Question: What caption would you write for this figure?
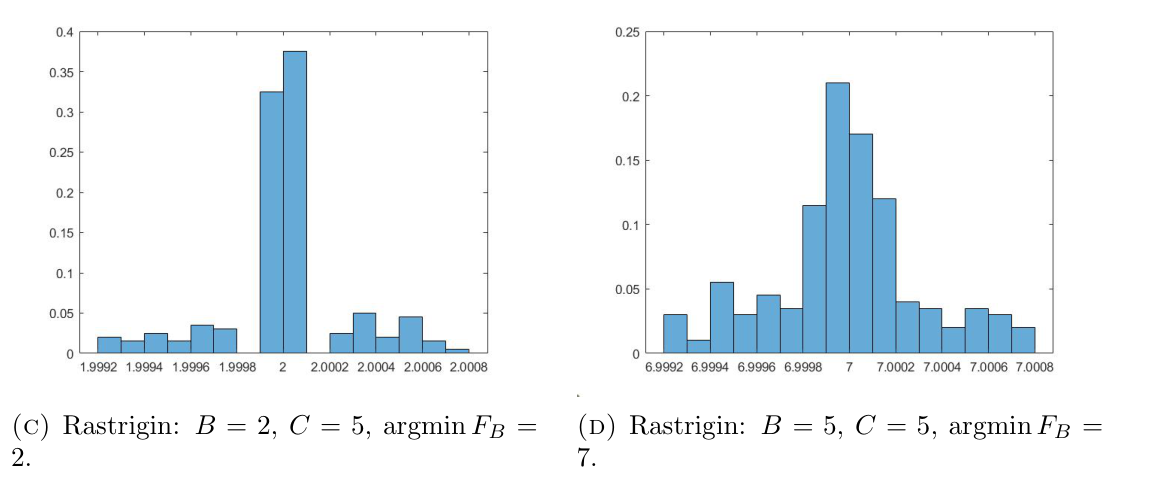
Answer: 4. Histograms of the shifted 1D Ackley function by 200 experi- ments. B = 25, C = 5. Global minimum min FAckley = 5 is attained at x∗= 25.